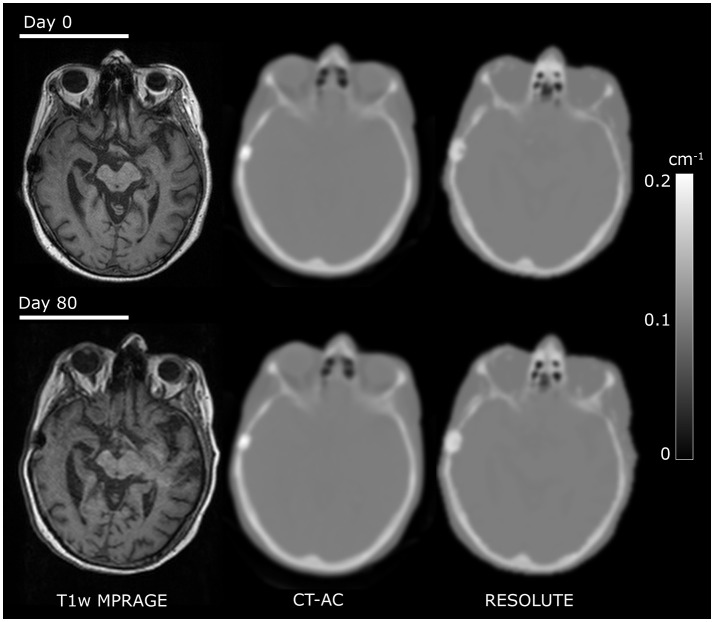
Comparison of CT and RESOLUTE my-maps. Co-registered images from a patient [F, 65 y/o, glioblastoma multiforme (WHO IV)] examined twice within 80 days illustrating good my map repeatability.